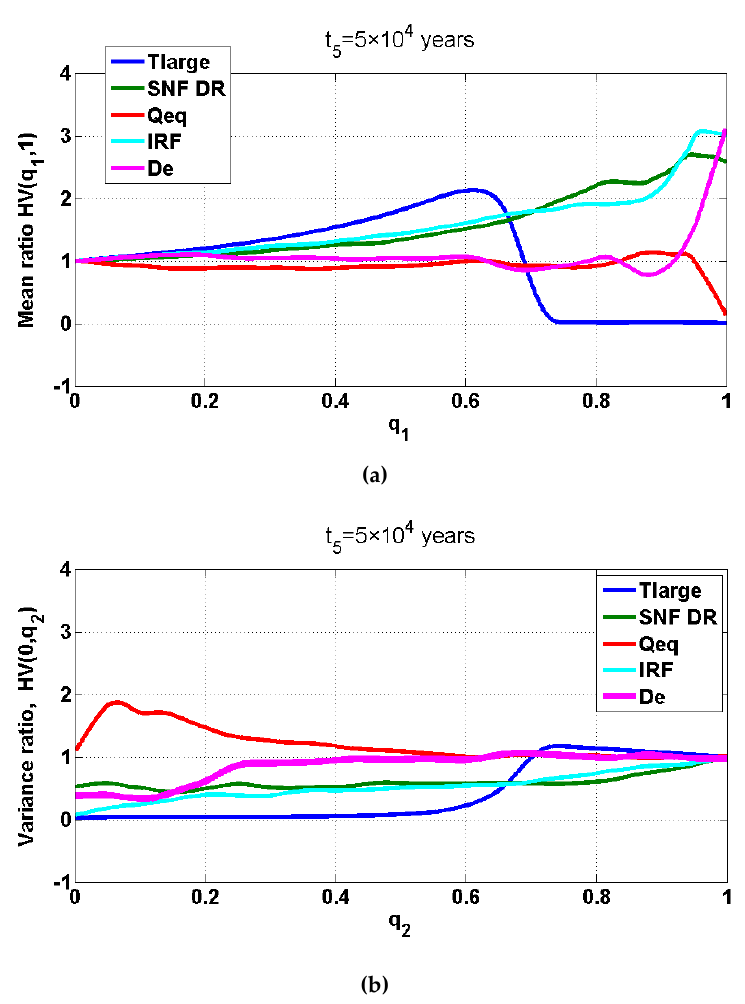
Figure 10. The variance ratio functions (HV) due to ( a ) reduced upper bound and ( b ) increased lower bound of the range of parameters (Tlarge, SNF DR, Qeq, IRF, De) at t 5 = 5 × 10 4 years after repository closure (smoothed by the regression technique) (Tlarge—defect size enlargement time, SNF DR—SNF matrix dissolution rate, Qeq—equivalent groundwater flow rate around the canister, IRF—instant release fraction, De—effective diffusivity of I-129 in bentonite).